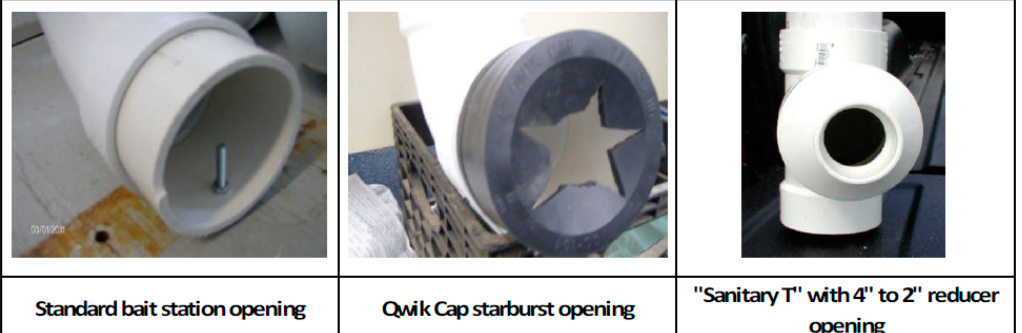
Figure 4. Candidate bait station modifications reducing non-target bait uptake in Barnstable County, Massachusetts and in Polk County, Florida, in 2011.